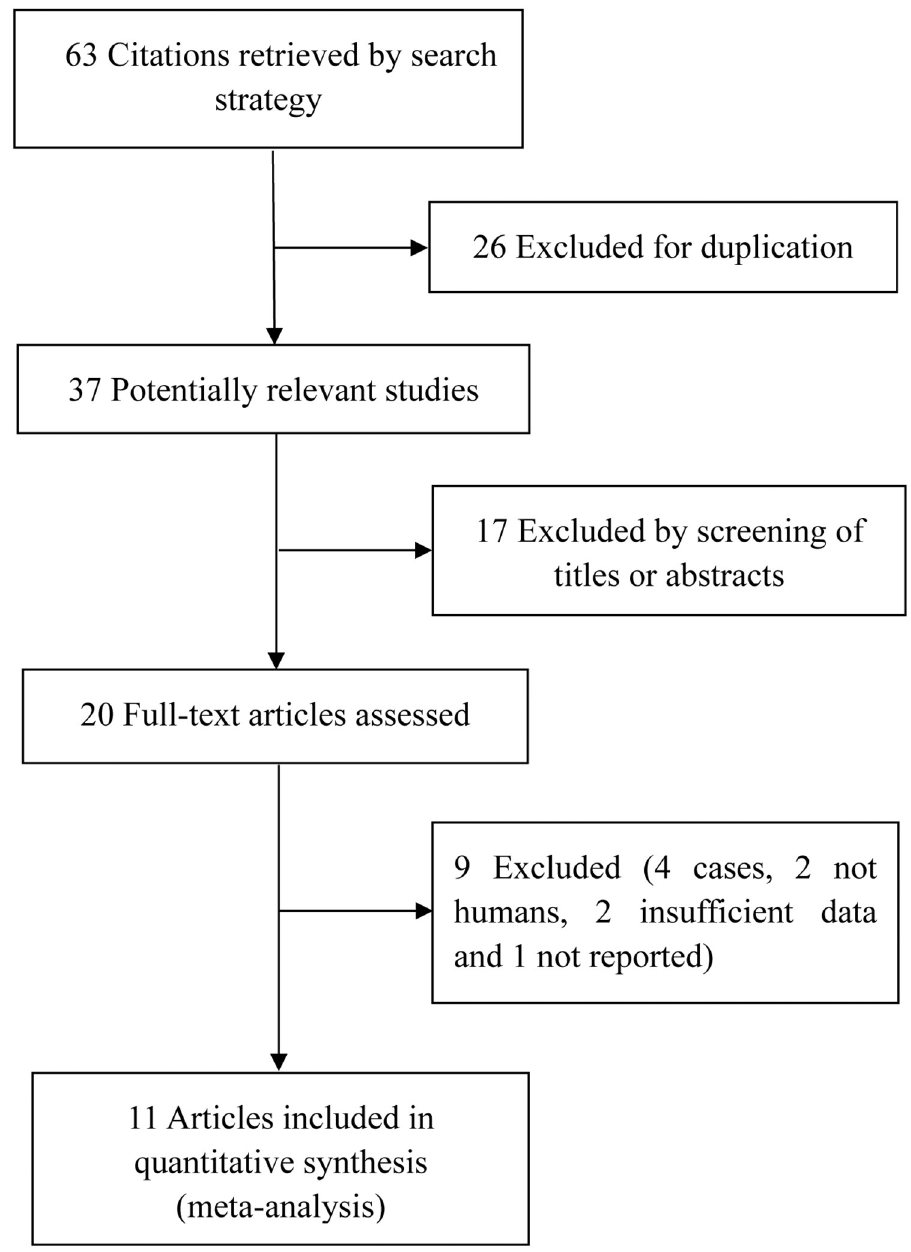
Fig 1. Selection process for studies included in the